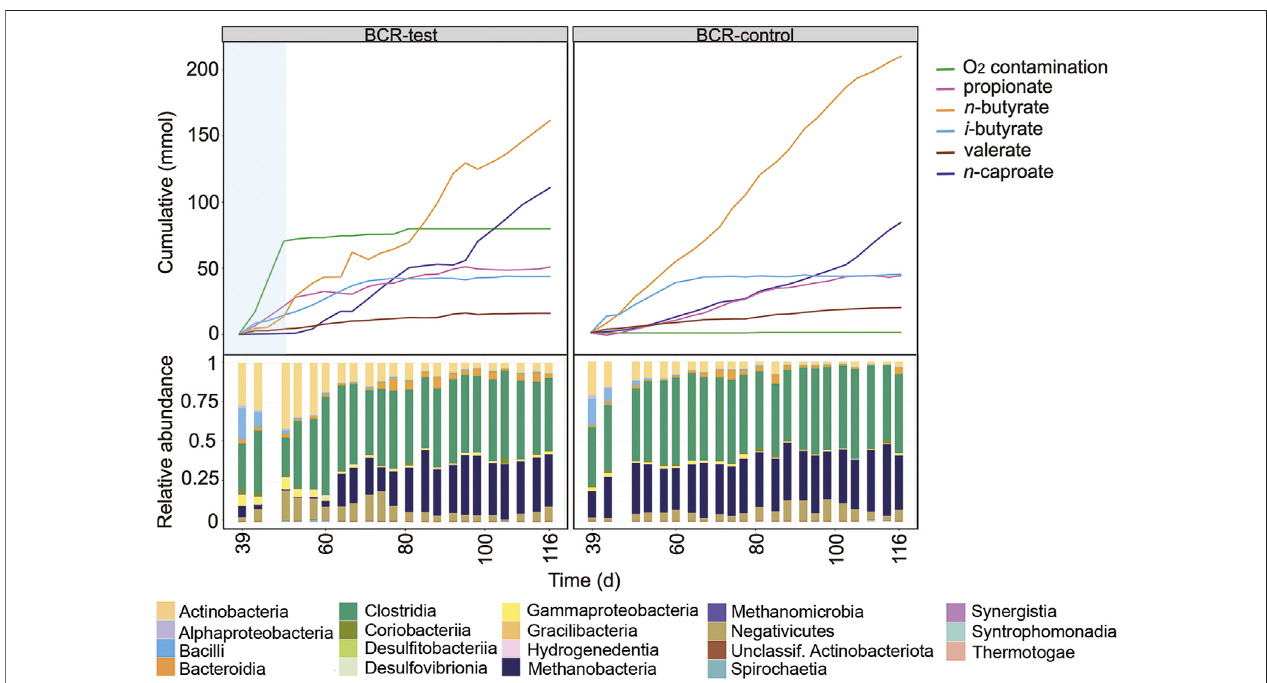
FIGURE5| Pro fi lesofthecumulatedamountsofcarboxylatesandO 2 ,aswellascommunitycompositionatclasslevelbetweendays39and116forBCR-testand BCR-control. Blue shading indicates the O 2 contamination period.